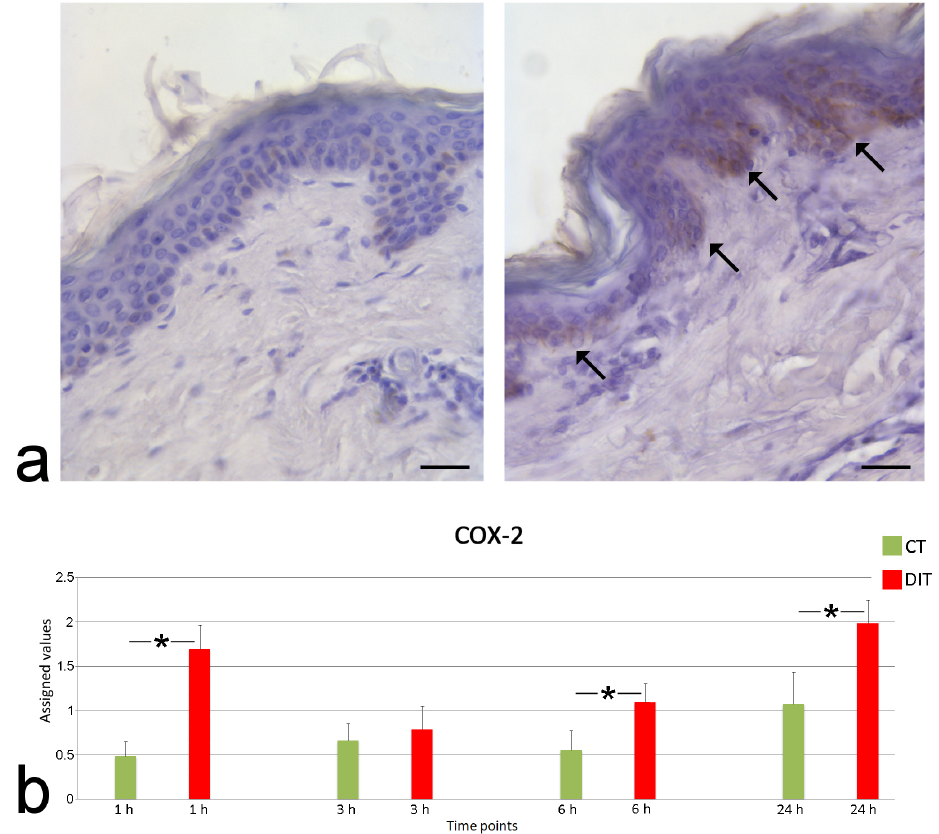
Figure 7. ( a ) Skin sample untreated ( left ) and treated with dithranol for 1 h ( right ); immunolabelling with anti-COX-2 antibody. Keratinocytes of the treated sample show an evident signal (arrows). Bars: 50 µ m. ( b ) Mean ± standard error values of labeling values. Asterisks indicate significant difference (3 h CT vs. 3 h DIT, p < 0.001; 6 h CT vs. 6 h DIT, p = 0.013; 24 h CT vs. 24 h DIT, p = 0.009). CT, control (untreated); DIT, dithranol-treated.